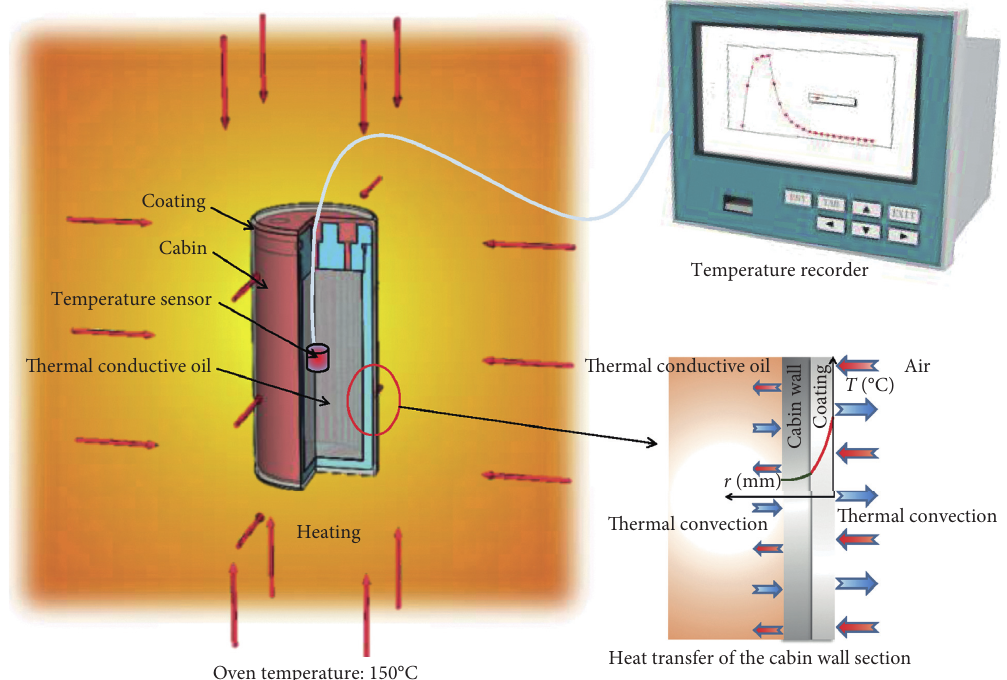
Figure 14: Passive thermal insulation material effectiveness test.